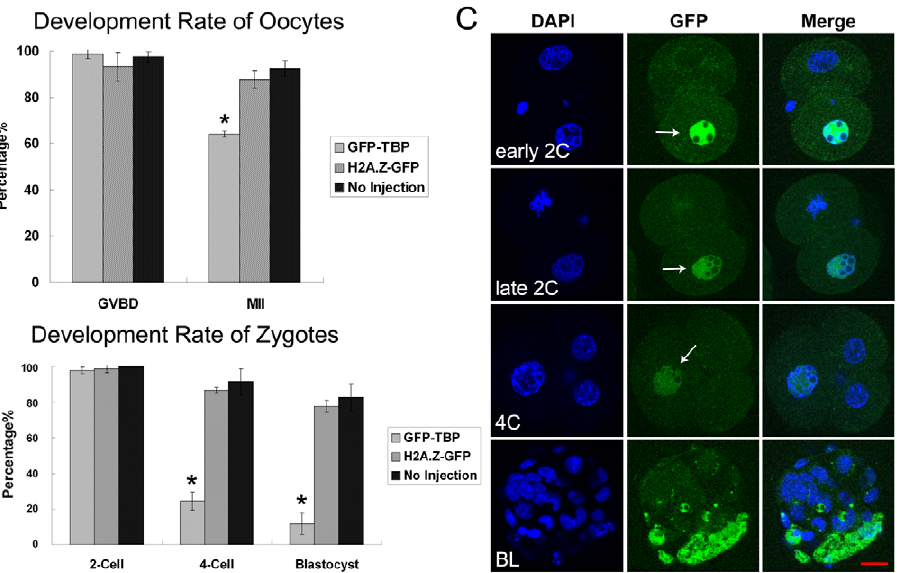
Figure 4. Effects of GFP-TBP overexpression on mouse oocyte maturation and embryo development. ( A ) Rates of GVBD oocytes and MII oocytes in GFP-TBP overexpression group. Overexpression of TBP had no effect on oocyte GVBD compared with control group, but rate of MII stage oocyte was significantly lower that the control group. ( B ) Rates of 2-cell embryo, 4-cell embryo and blastocyst in GFP-TBP overexpression group. Overexpression of TBP had no effect on the first cleavage, but the rate of 4-cell was significantly lower than the control group. Moreover, the rate of blastocyst was also significantly lower than the control group. ( C ) The embryo development after the injection of GFP-TBP mRNA into one cell of 2- cell embryos. The cell which was injected with GFP-TBP mRNA failed to undergo cell division. The cell with no injection showed normal cell division. Arrow shows the nucleus localization of exogenous TBP expression. *, significantly different (p , 0.05). Bar=20 m m. Figure S2 Identification of the expression of H2A.Z-GFP in the interphase, M phase of zygotes and 2-cell embryos. In the interphase, H2A.Z-GFP expressed in the nucleus; in the mitotic phase, H2A.Z-GFP expressed at the chromosomes. Zygote I: Zygote Interphase; Zygote M: Zygote Mitotic phase; 2-Cell I: 2-Cell Interphase; 2-Cell M: 2-Cell Mitotic phase; Bar= 50 m m. (TIF) Figure S1 Identification of the expression of GFP-TBP mRNA in oocytes and zygotes. GFP-TBP successfully expressed in the germinal vesicle of oocytes and pronucleus of zygotes. The constructed GFP-TBP mRNA was also identified. Bar =50 m m.